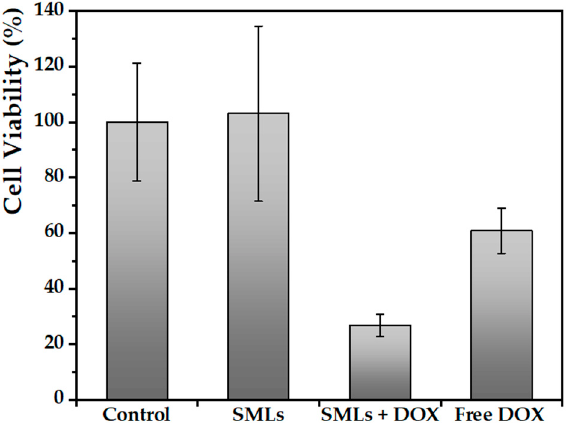
Figure 9. Viability of untreated HepG2 cancer cells (control) and in the presence of solid magnetoliposomes without DOX (SMLs) and with DOX encapsulated at 5.65 × 10 − 5 M (SMLs + DOX), as well as in the presence of drug in free form at 5.65 × 10 − 5 M (Free DOX).